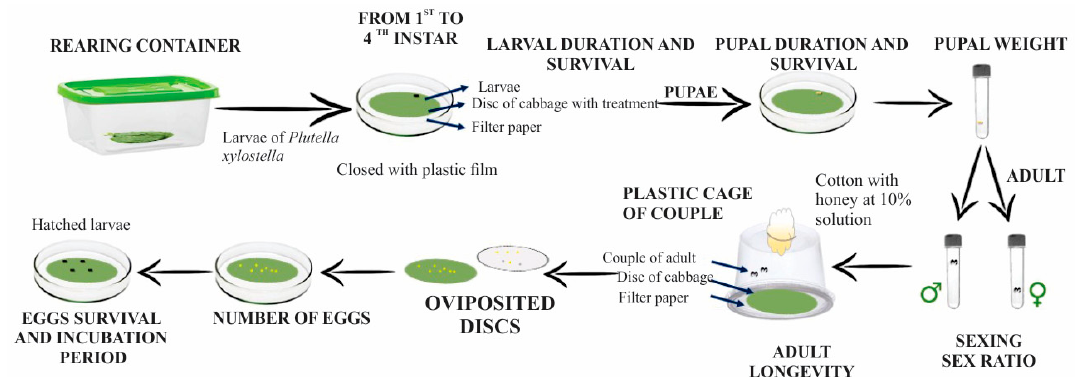
Figure 2. A schematic representation of the methodology used for evaluation of biological parameters, by Matias da Silva et al. [34].